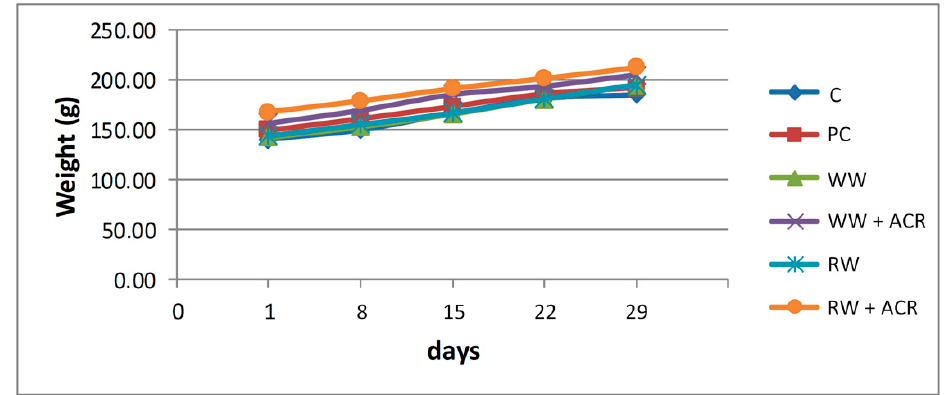
Figure 1. The evolution of the average body weight of the animals from the 6 groups, during the entire experimental period. C − hydroalcoholic solution group; PC − hydroalcoholic solution + acrylamide group; WW − white wine group; WW + ACR − white wine + acrylamide group; RW − red wine group; RW + ACR − red wine + acrylamide group.